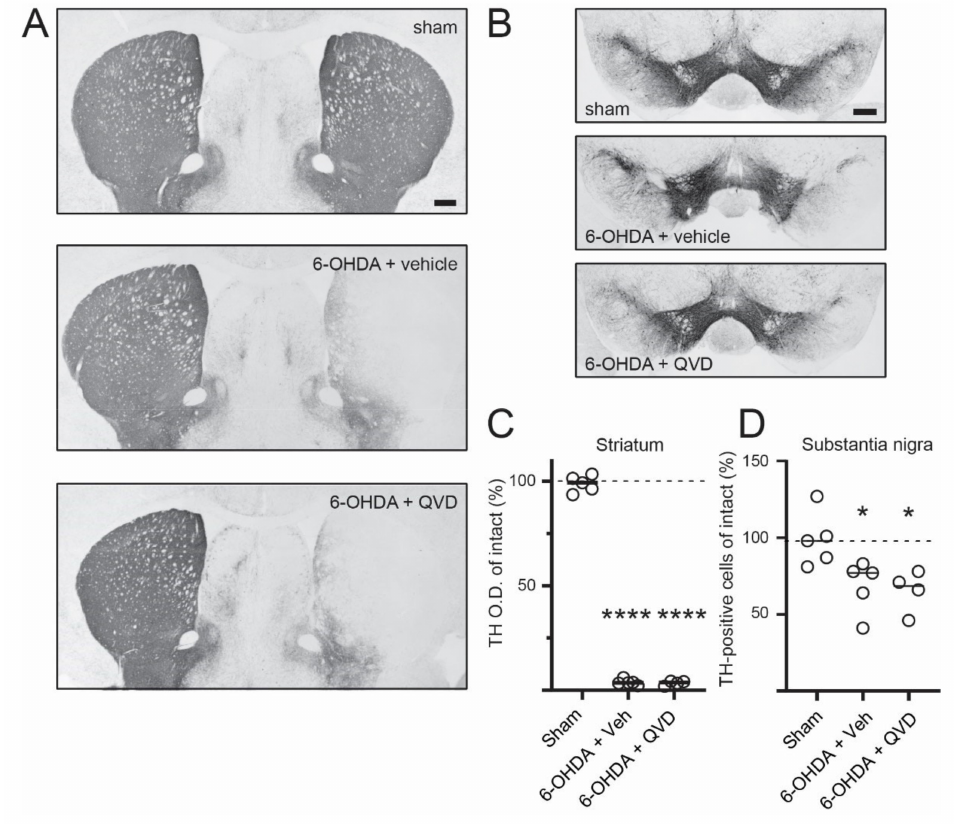
Figure 4. Q-VD-OPh treatment does not protect against 6-OHDA-induced dopaminergic degenera- tion. ( A , B ) Low-magnification images of striatal ( A ) and nigral ( B ) sections immunostained for TH, with the side ipsilateral to the 6-OHDA lesion on the right. Scale bar: 400 µ m ( C ) Densitometric analysis shows that the loss of striatal DAergic innervation does not differ between vehicle- and QVD-treated animals. **** p < 0.0001 vs. sham, ANOVA and post hoc Bonferroni test, N = 4–5. ( D ) Stereological cell counts show that the 6-OHDA-induced loss of nigral DA neurons is not pre- vented by QVD treatment. * p < 0.05 vs. sham, ANOVA and post hoc Bonferroni test, N =